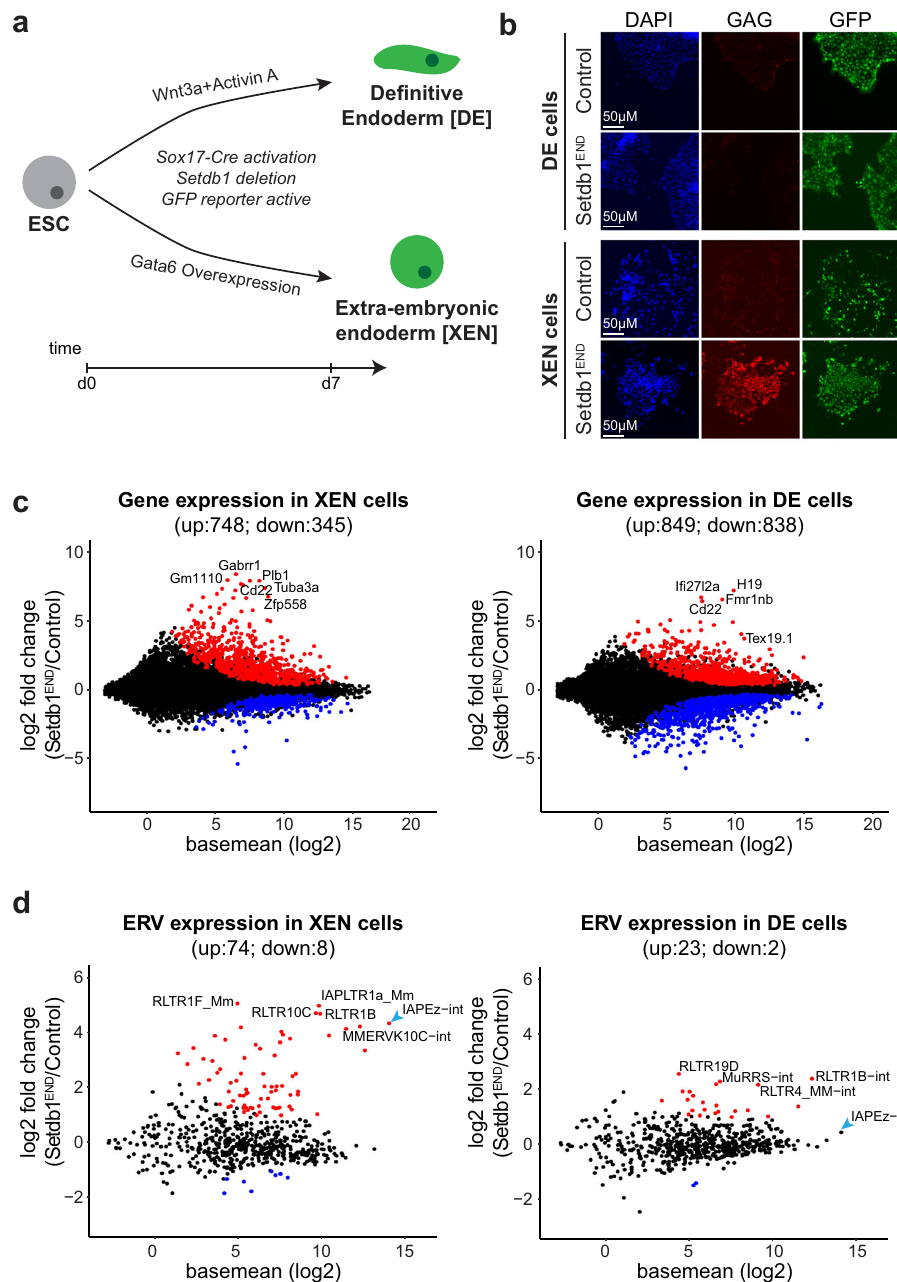
Fig.3|Setdb1iscriticalforIAPsilencinginvisceralendodermprogenitors,but notinde fi nitiveendodermcells.a Schematicofinvitroendodermdifferentiation ofcontrolandSetdb1 END ESCs.De fi nitiveendodermcellsweregeneratedbyWnt3a/ Activin stimulation. Visceral endoderm progenitor (XEN) cells were generated by overexpression of Gata6. b Immuno fl uorescence staining of in vitro differentiated control and Setdb1 END endoderm cells. Cells were stained after 7 days of in vitro differentiation using IAP-GAG (marks IAP de-repression) and GFP (marks Cre reporteractivity)antibodies.StrongIAPde-repressionisonlyobservedinSetdb1 END XEN cells. Representative images from n =3 experiments. c Dot plot showing basemean expression vs. log2-fold change of protein coding genes in in vitro